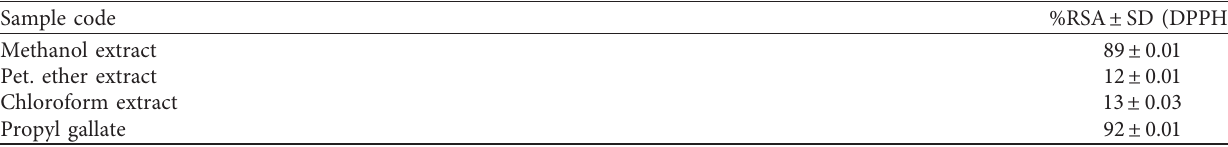
Table 1: Antioxidant activity B. rufescens extracts.